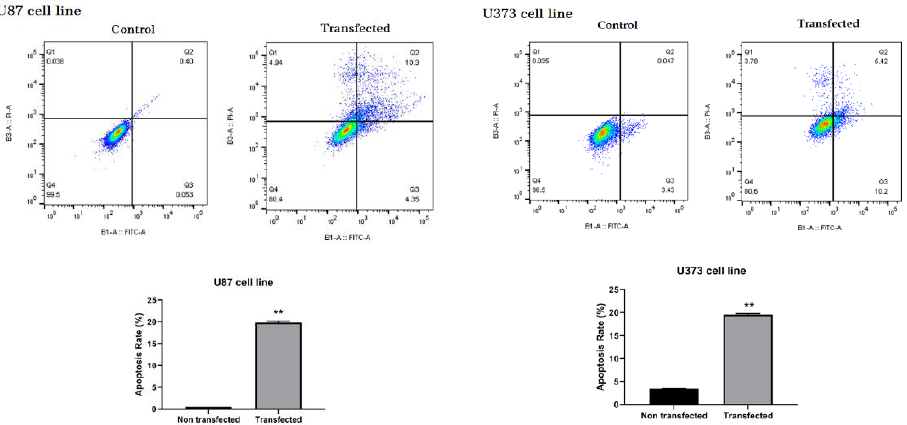
creased arrest in the G0/G1 phase leading to fewer the other checkpoints in comparison to control in U373 cells. ( B ) Transfection induced DNA damage and apoptosis in U87 cell line. * p < 0.05, ** p < 0.01.